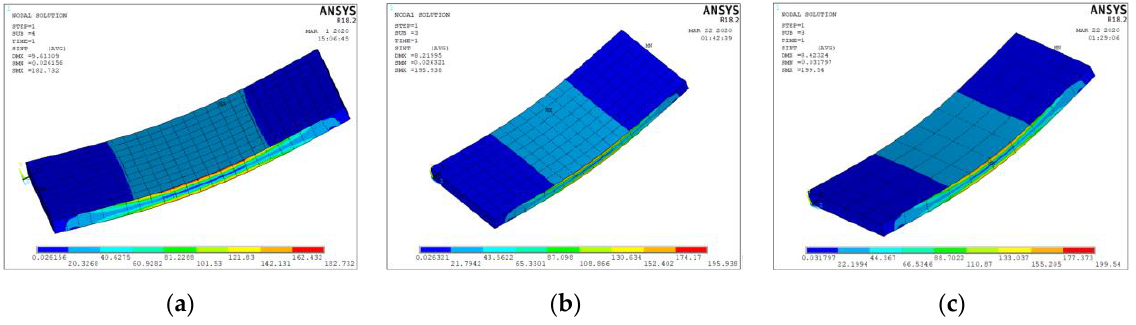
Figure 21. Deflection nephogram of composite floor with different cavity size: ( a ) 100, ( b ) 125 and ( c )